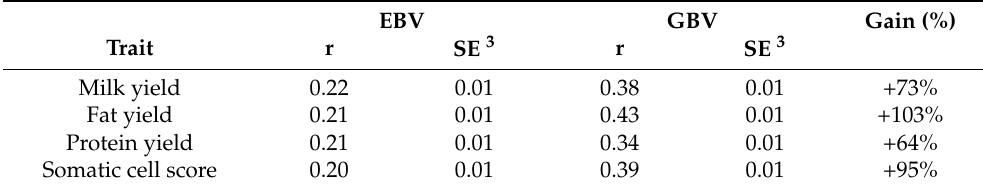
Table 3. Accuracies (r) of the across-breed breeding values (EBVs) and genomic breeding values (GBVs) of milk traits for animals in the validation population using the PBLUP 1 and ssBC 2 methods, n =